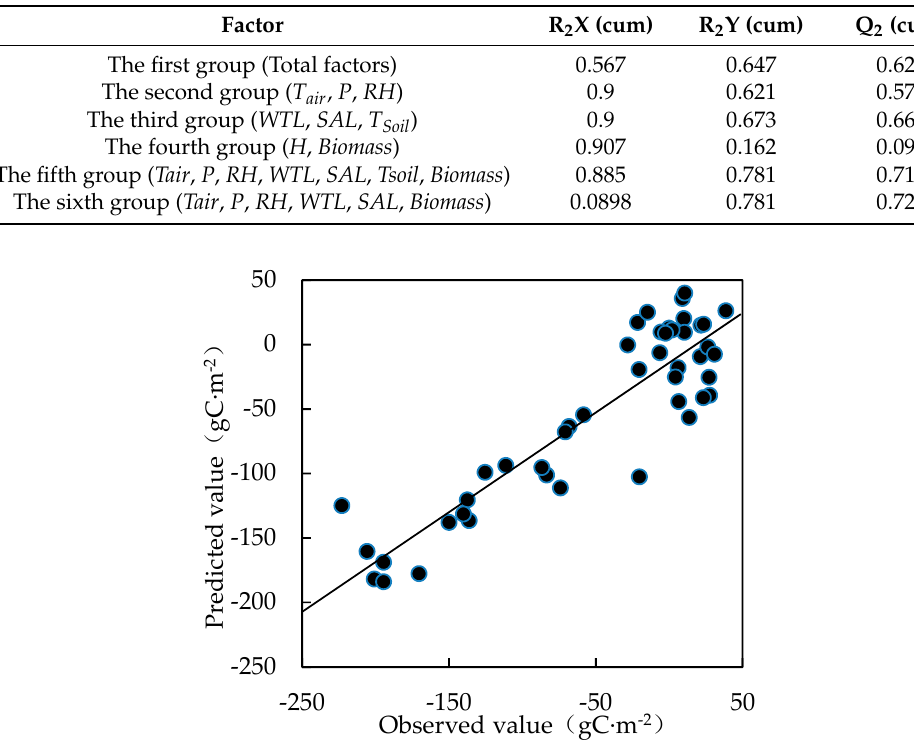
Figure 11. Scatter plots of the observed and simulated values of CO 2 monthly exchange.